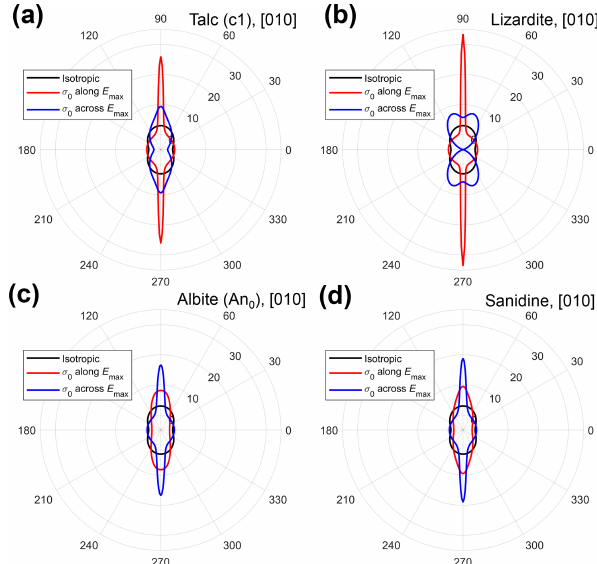
Figure 21. Predictions of stresses around cracks in thin 2D or- thotropic plates. Curves show the directional variations in the cir- cumferential stress ( σ θθ ) normalised by the applied uniaxial tensile load ( σ 0 ) . (a) Talc (c1, triclinic), (010) plane. (b) Lizardite, (010) plane. (c) Albite, (010). (d) Sanidine,